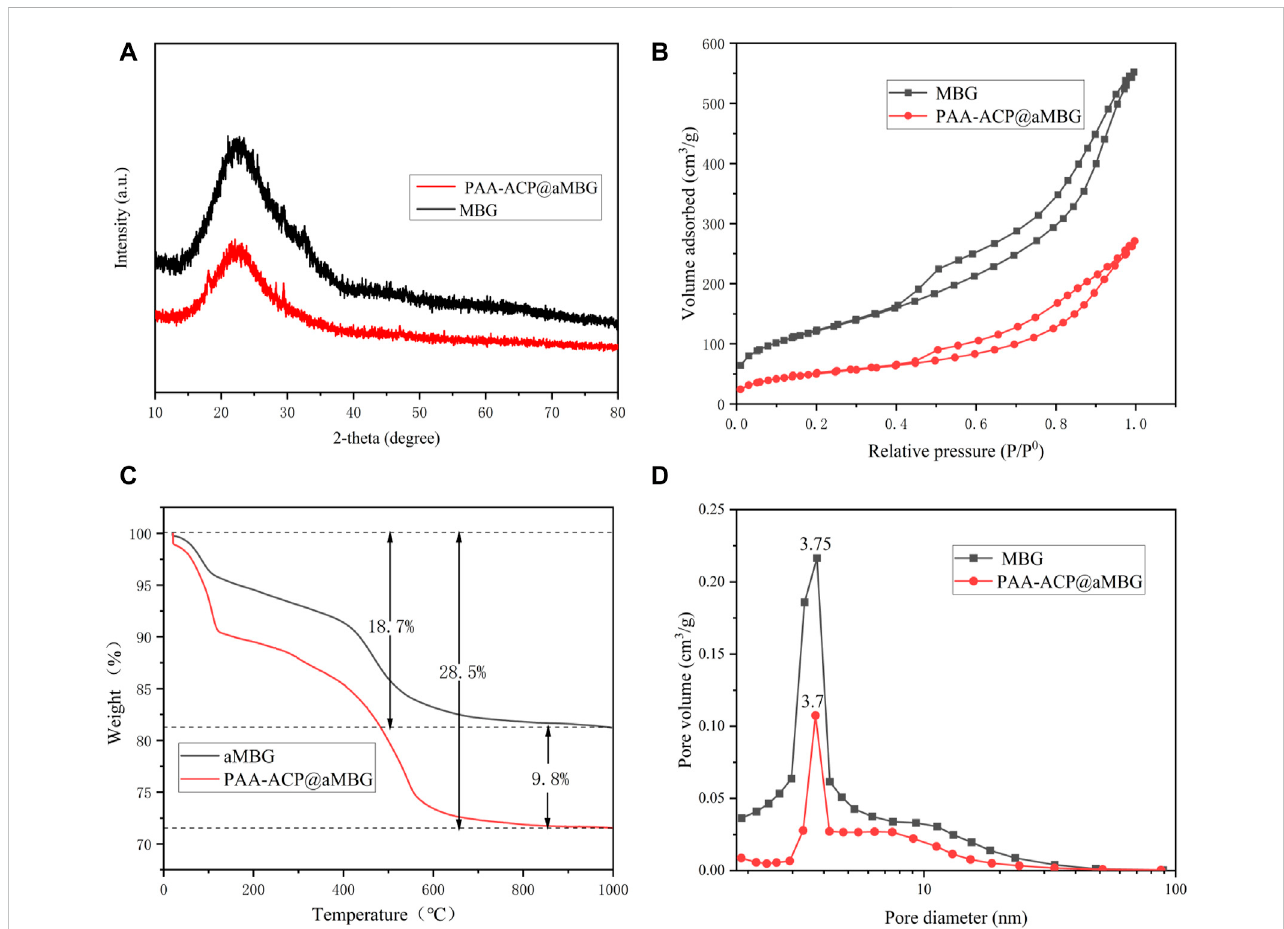
FIGURE 1 Characterization of MBG/aMBG/PAA-ACP@aMBG. (A) X-ray diffraction patterns of MBG and PAA-ACP@aMBG. (B) Nitrogen adsorption-desorption analysis of MBG and PAA-ACP@aMBG. (C) Thermogravimetric analysis of aMBG and PAA-ACP@aMBG. (D) Pore size distributions of MBG and PAA-ACP@ aMBG.